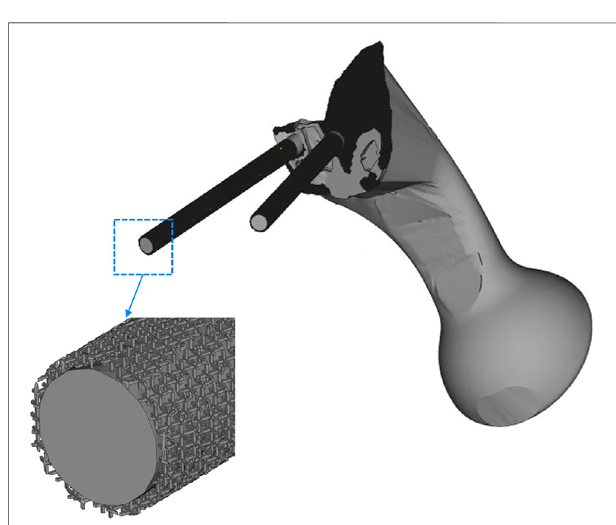
FIGURE 5 | The middle two areas of the connecting plate are optimized andremoved,andaporousstructurewithaporosityof30%wasaddedtothe screw surface and the high-density area of the connecting